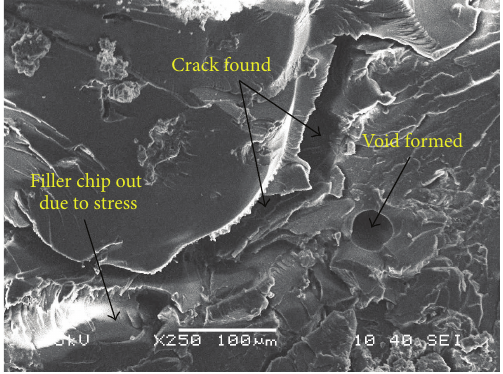
Figure 10: SEM of 20 wt% flexural specimen.